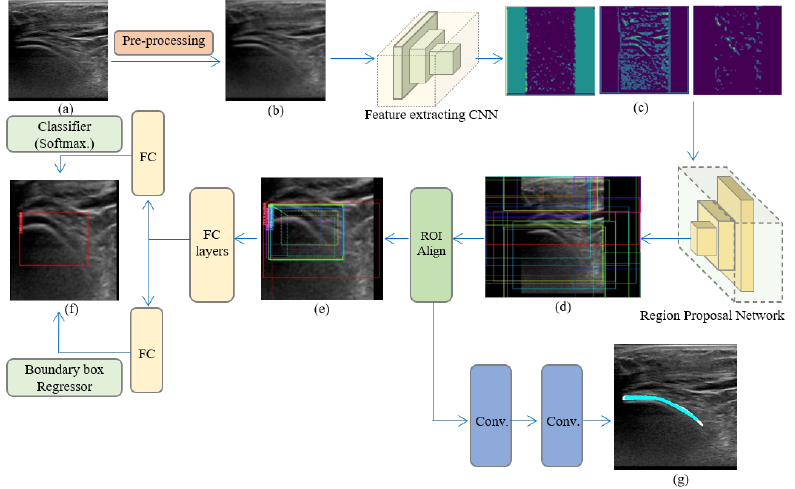
Figure A1. Flow diagram of the network ( a ) original image; ( b ) pre-processed image; ( c ) feature-maps; ( d ) proposed ROIs; ( e ) ROI Alignment output; ( f ) boundary-box regressor; ( g ) predicted mask (cyan) along with the ground truth (white) (Conv.—convolutional layers, FC—Fully Convolutional Network, ROI—Region of